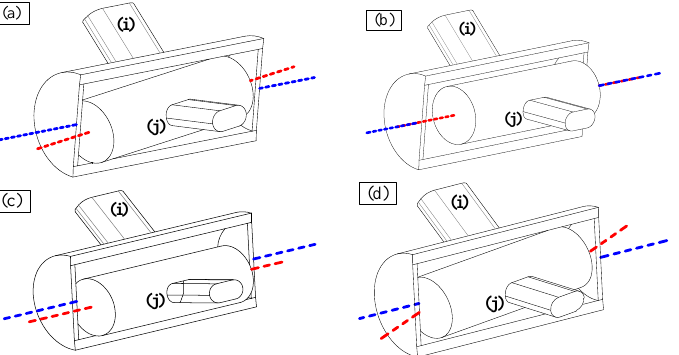
Figure 4. Different states of the journal in the sleeve. ( a ) horizontal deflection. ( b ) pan horizontally. ( c ) vertical translation. ( d ) vertical deflection.